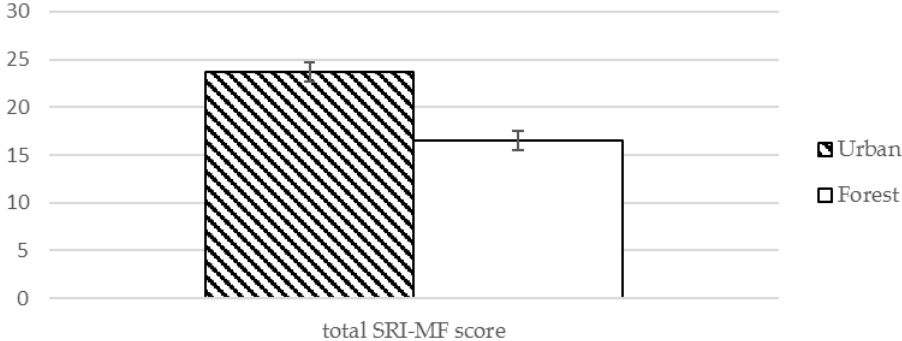
Figure 1. Effect of exposure to forest environment on total SRI-MF score. Table 3. Effect of exposure to forest environment on SRI-MF and its sub-scales.